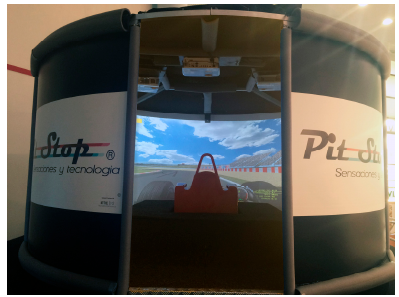
Figure 9. A user testing the Formula 1 (F1) virtual simulator.